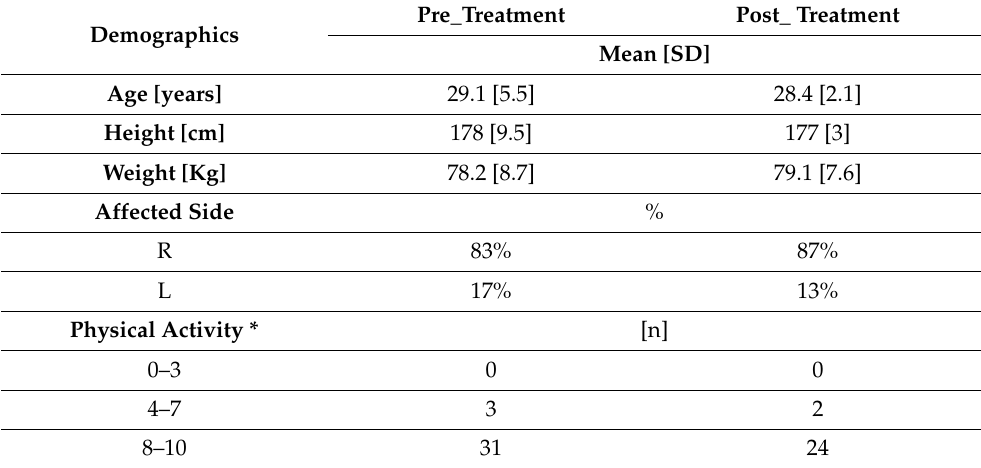
Table 1. Demographic data of study participants.